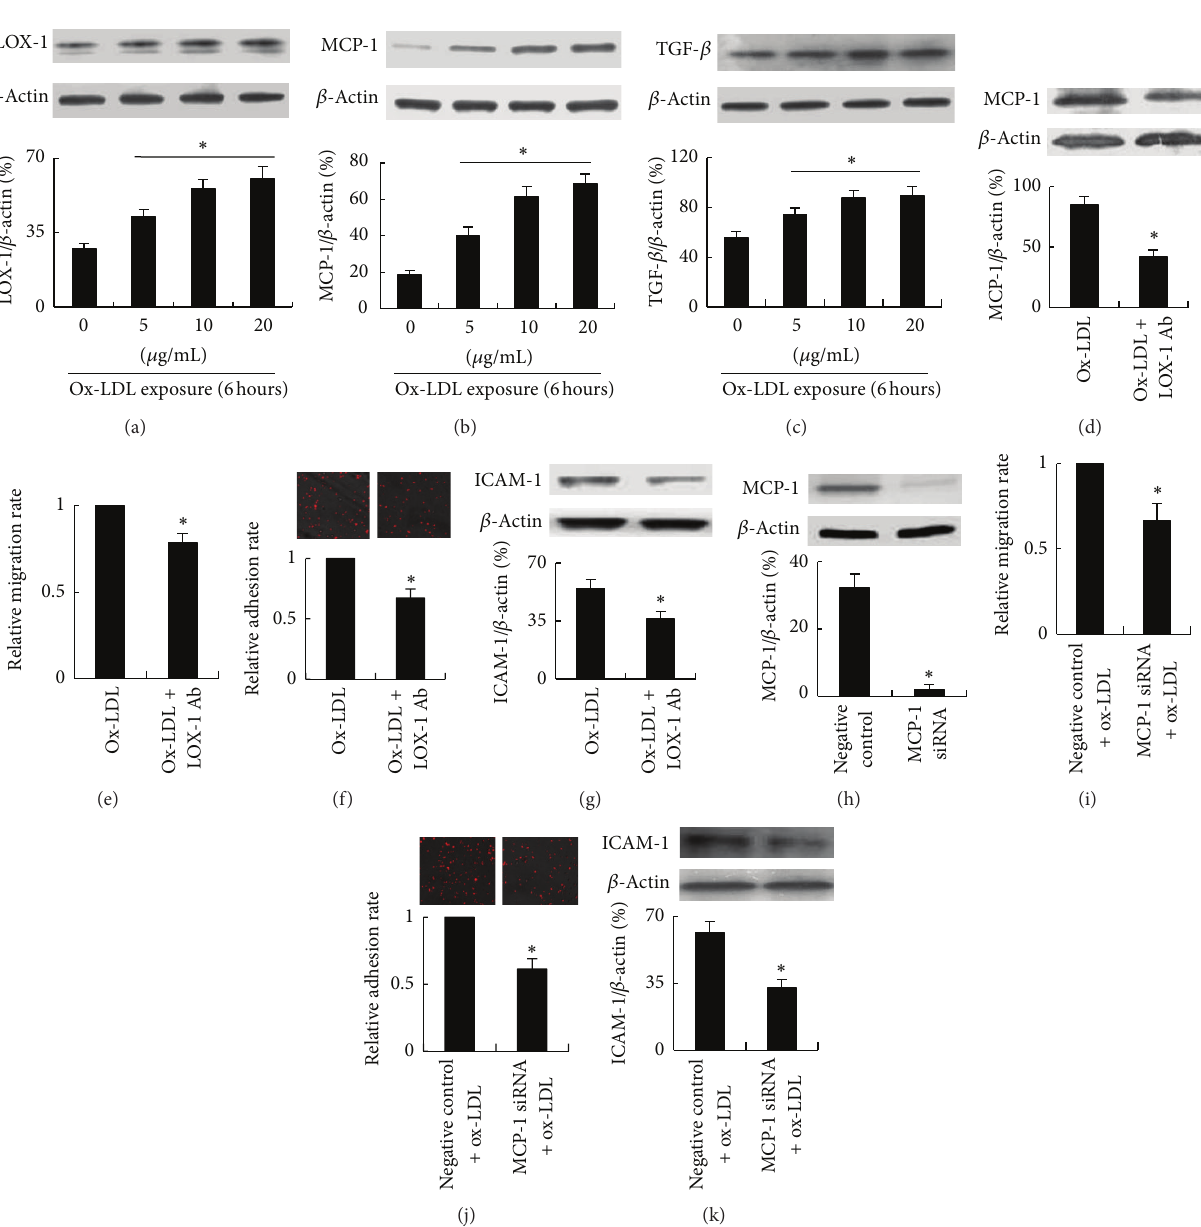
ox-LDL-induced bmMSC transmigration and cell